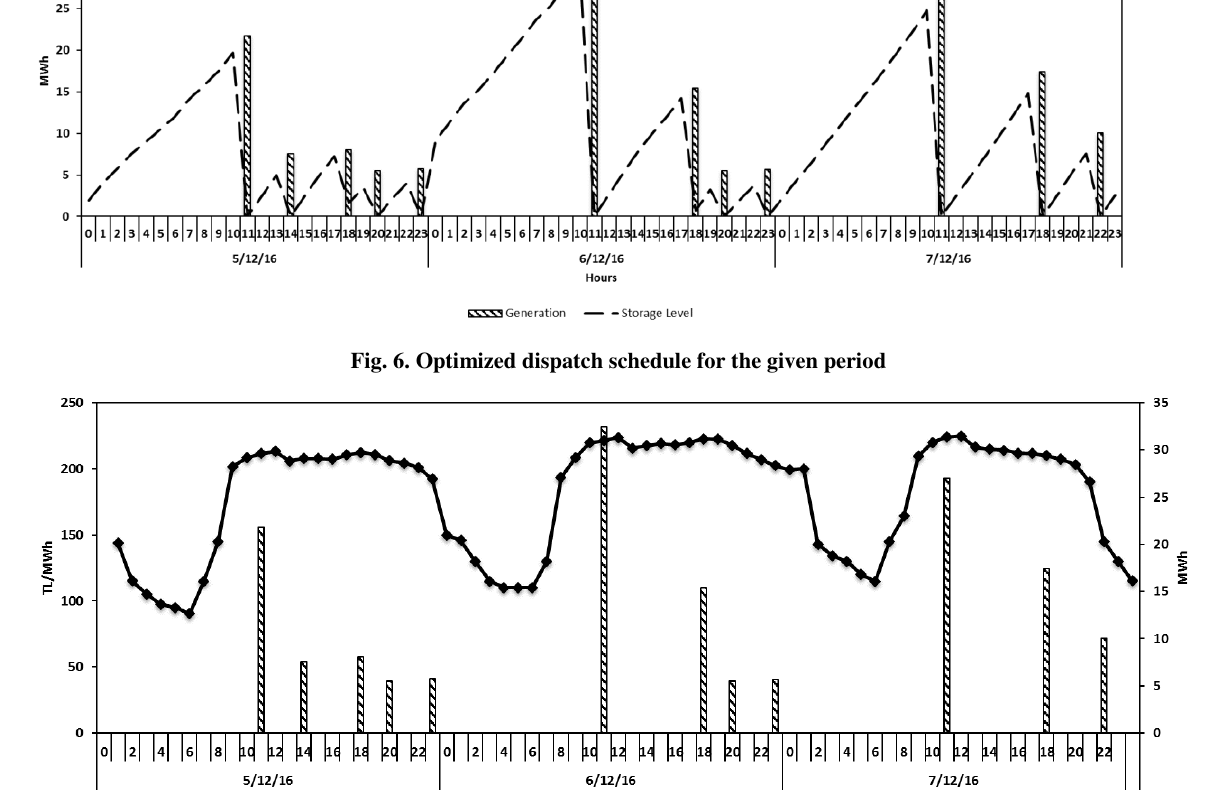
Fig. 7. Optimized dispatch schedule compared with realized day-ahead